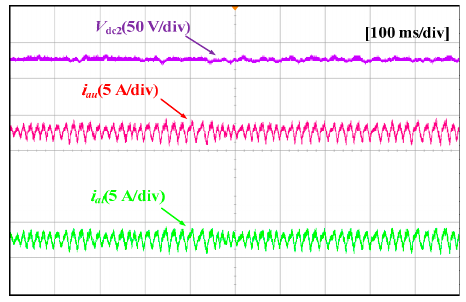
Figure 17. SM capacitor voltages of the proposed DC-DC MMC.